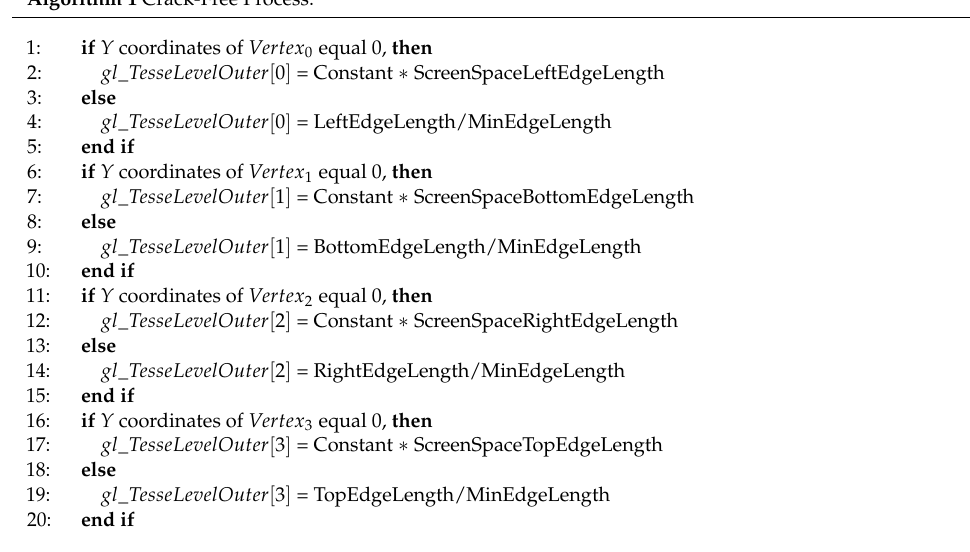
Algorithm 1 Crack-Free